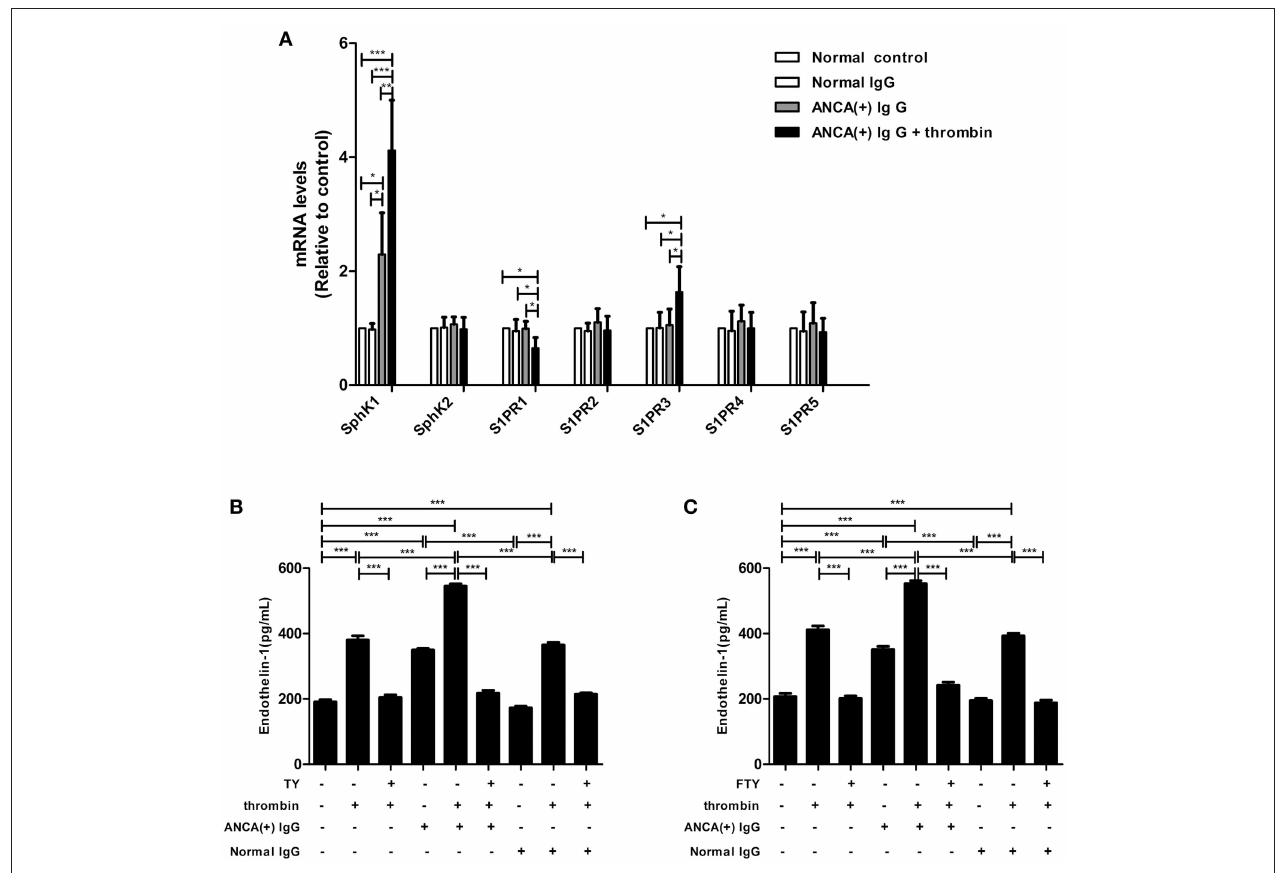
FIGURE 3 | SphK1–S1P-S1PR3 signaling was involved in thrombin -induced MPO-ANCA-positive IgG-mediated GEnC activation. (A) SphK1 and S1PR3 expression levels were elevated in MPO-ANCA-positive IgG-treated GEnCs upon thrombin stimulation. (B) S1PR3 mediated the thrombin-induced ET-1 upregulation in MPO-ANCA-positive IgG-treated GEnCs. (C) FTY720 significantly downregulated ET-1 levels in the supernatants of GEnCs stimulated by thrombin and MPO-ANCA-positive IgG. Bars represent mean ± SD of repeated measurements of five independent experiments or donors. * P < 0.05, ** P < 0.01, *** P < 0.001.